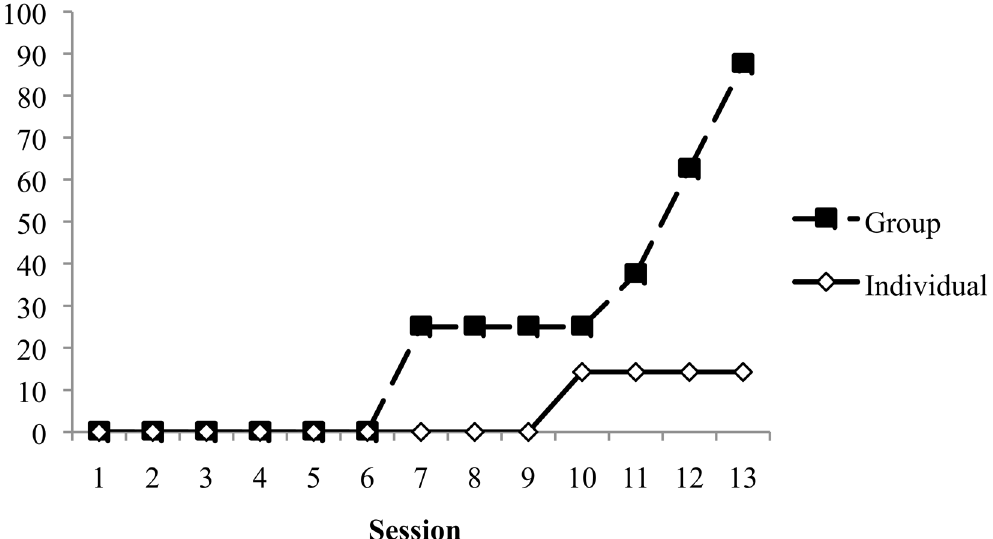
Fig 1. Percentage of calves meeting the learning criterion by treatment over the course of training in the reversal learning task, in Experiment 1. Fewer individual calves successfully learned the reversed colour discrimination by the end of training. n = 7 individual, 8 group calves.